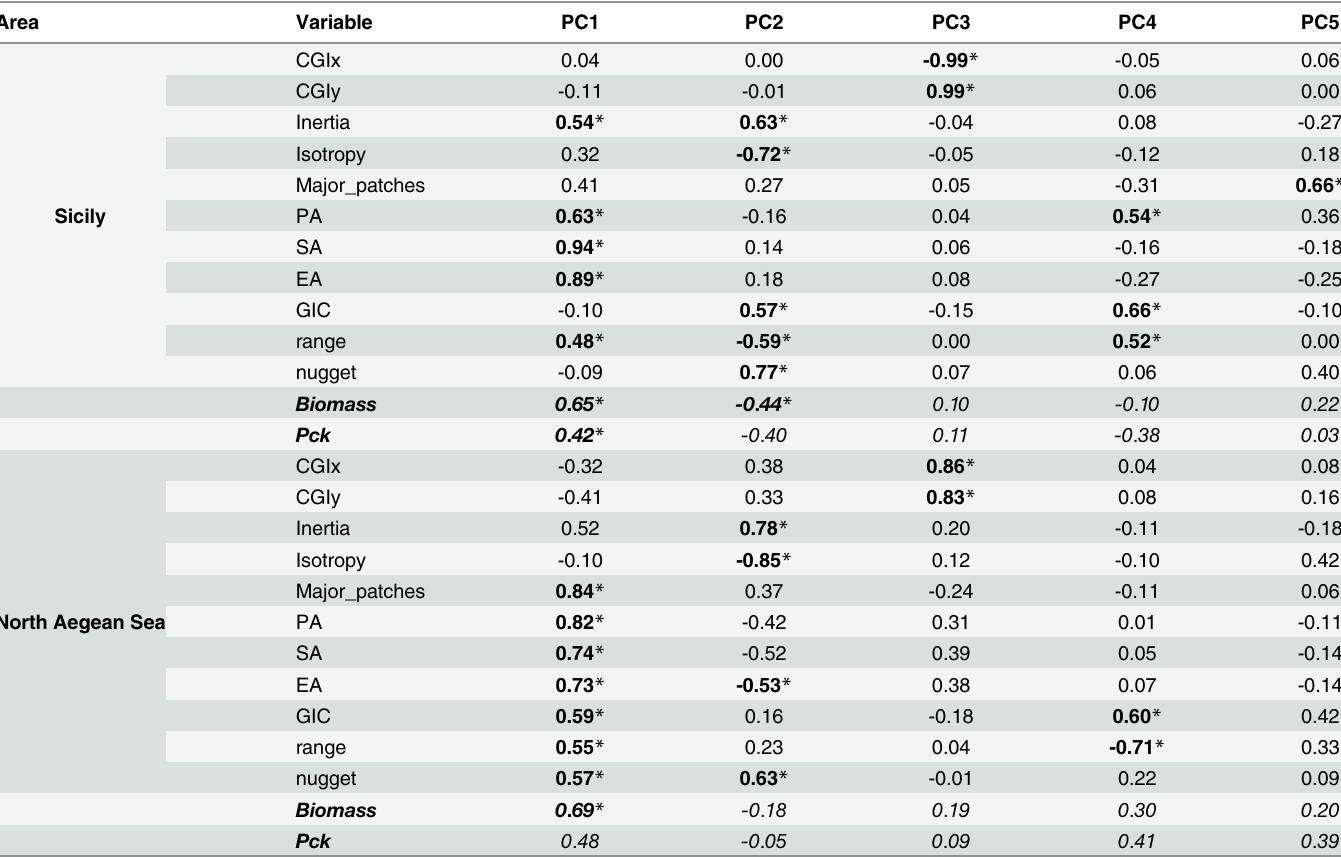
Table 3. Principal Component loadings per area. Supplementary variables are shown in italics. Significantly correlated variables on each axis are marked with an ( * ) and shown in bold.